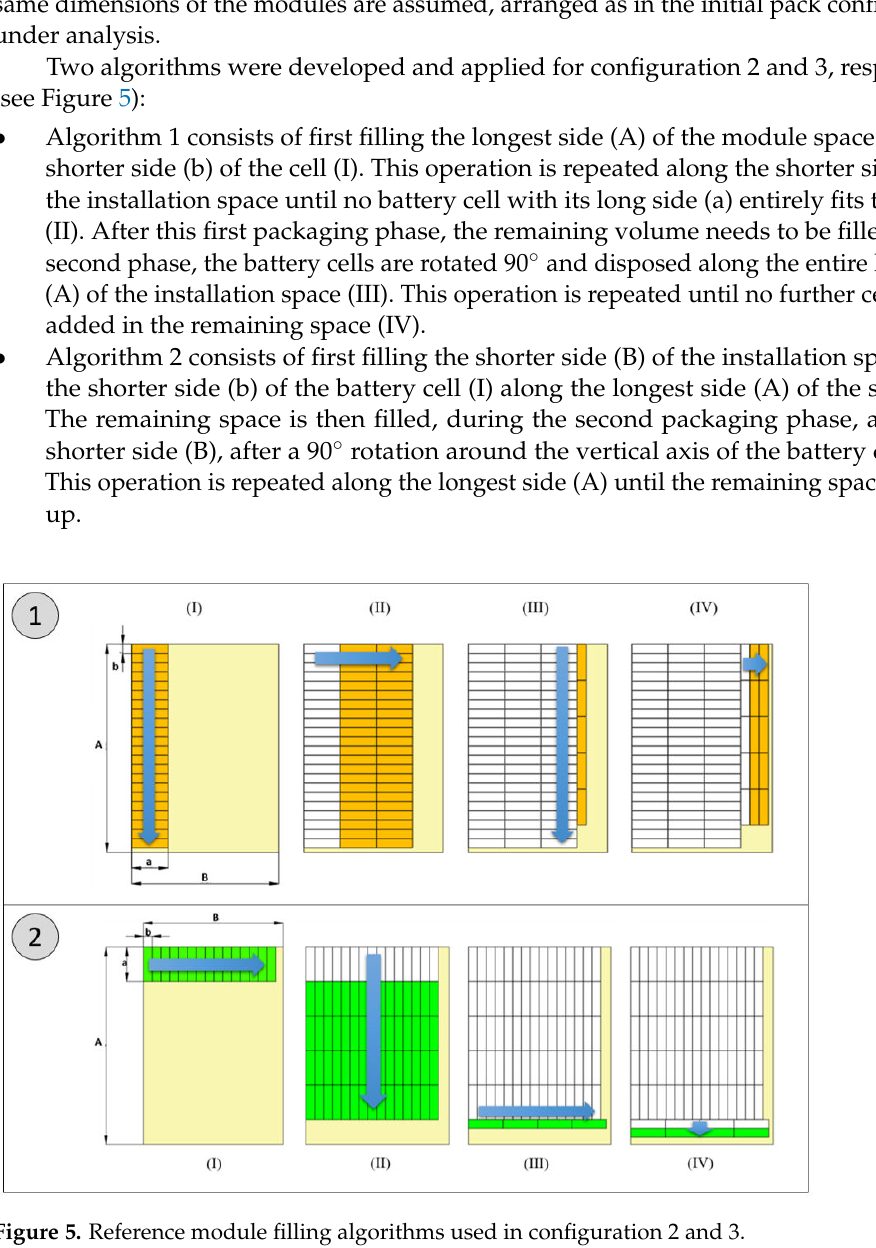
Figure 5. Reference module filling algorithms used in configuration 2 and